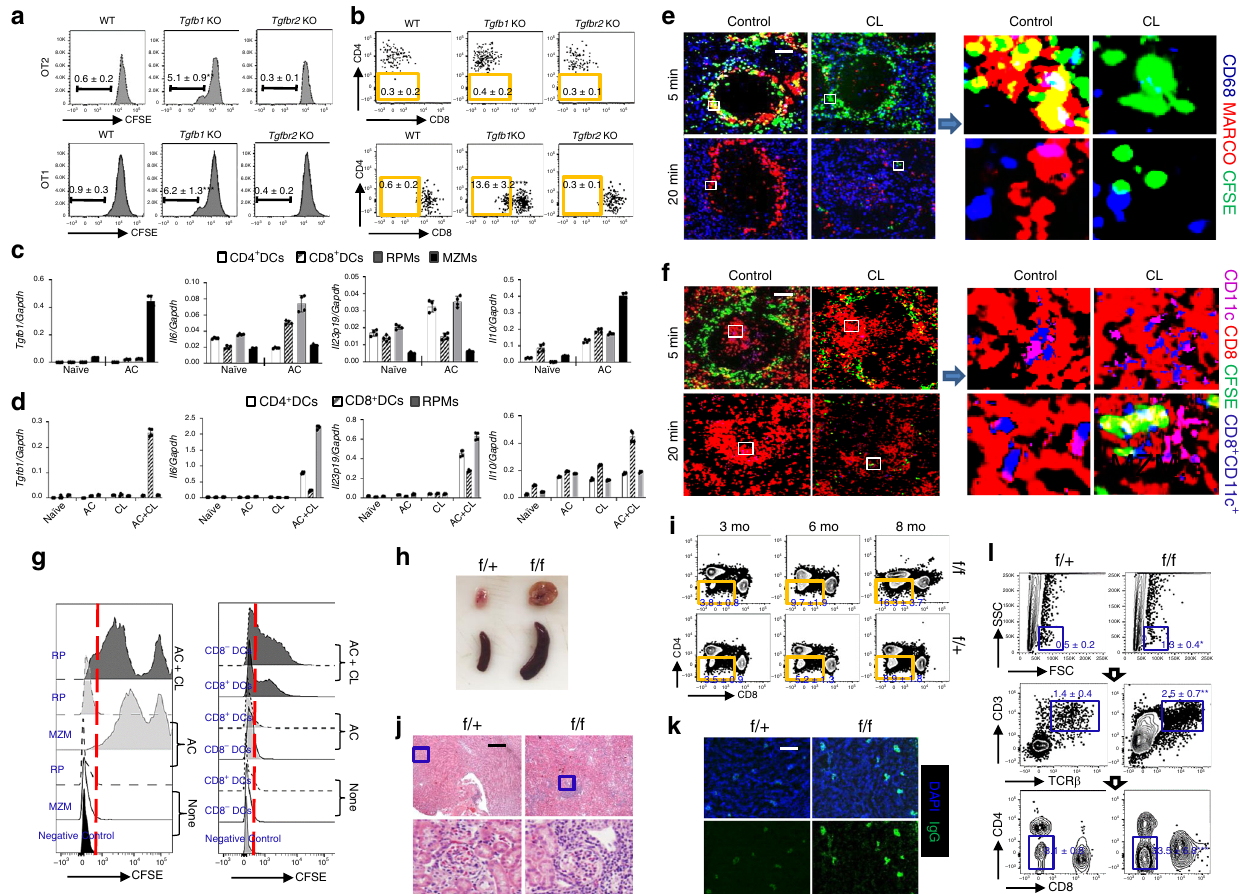
Fig. 5 De fi ciency of Tgfb1 in macrophages promotes DN T-cell formation. a , b CFSE-labeled CD4 T cells from OT-II Rag1 − / − or CD8 T cells from OT-I Rag1 − / − B6 mice were co-transferred with apoptotic m-OVA thymocytes into the indicated recipients. Recipients were euthanized after an additional 72 h. n = 4 per group for two independent experiments. Flow cytometry analysis of proliferation ( a ) or surface CD4/CD8 expression ( b ) on transferred OT-I or OT-II T cells. c , d Apoptotic thymocytes were administered into mice pre-treated without ( c ) or with CL ( d ) for 2 h. MZMs, red pulp macrophages (RPMs or RPs), CD4 + DCs, and CD8 + DCs were FACS sorted 30 min later. qRT-PCR analysis of indicated gene expression in indicated cell populations sorted from mice administered with apoptotic thymocytes ( c ) or mice administrated with CLs plus apoptotic thymocytes ( d ). n = 4 per group. e – g CFSE- labeled apoptotic thymocytes were administered into mice with or without CL pre-treatment. n = 4 per group. Magni fi cation, ×20, scale bar: 50 μ m. e Confocal microscopic images show that in the absence of MZMs, administration of apoptotic thymocytes leads to follicular translocation of RPMs (CD68 + ). f Confocal microscopic images show the uptake of apoptotic cell debris by CD8 + dendritic cells in the absence of MZMs. g Flow cytometry shows the apoptotic cell uptake (CFSE + ) by indicated populations with indicated treatment. h , j – l Mice were at 12 months of age. h – l n = 5 per group for two independent experiments. h Representative photos of spleens and lymph nodes from indicated mice. i Flow cytometry quantitation of CD3 + TCR β + CD4 − CD8 − DN T cells in spleens or lymph nodes from indicated mice at indicated ages. j Fluorescence microscopic images of IgG staining in the kidneys of indicated mice. Magni fi cation, ×10, scale bar: 100 μ m. k Representative H&E images of kidneys from indicated mice. Upper: magni fi cation, ×4, scale bar: 200 μ m; Lower: Digitally magni fi ed views of the boxed areas in the upper panels. l Flow cytometry analysis of in fi ltrating T cells in the kidneys from indicated mice. Data represent the mean ± SEM (* P < 0.05, ** P < 0.01, *** P < 0.005 vs. control, two-tailed Student ’ s t